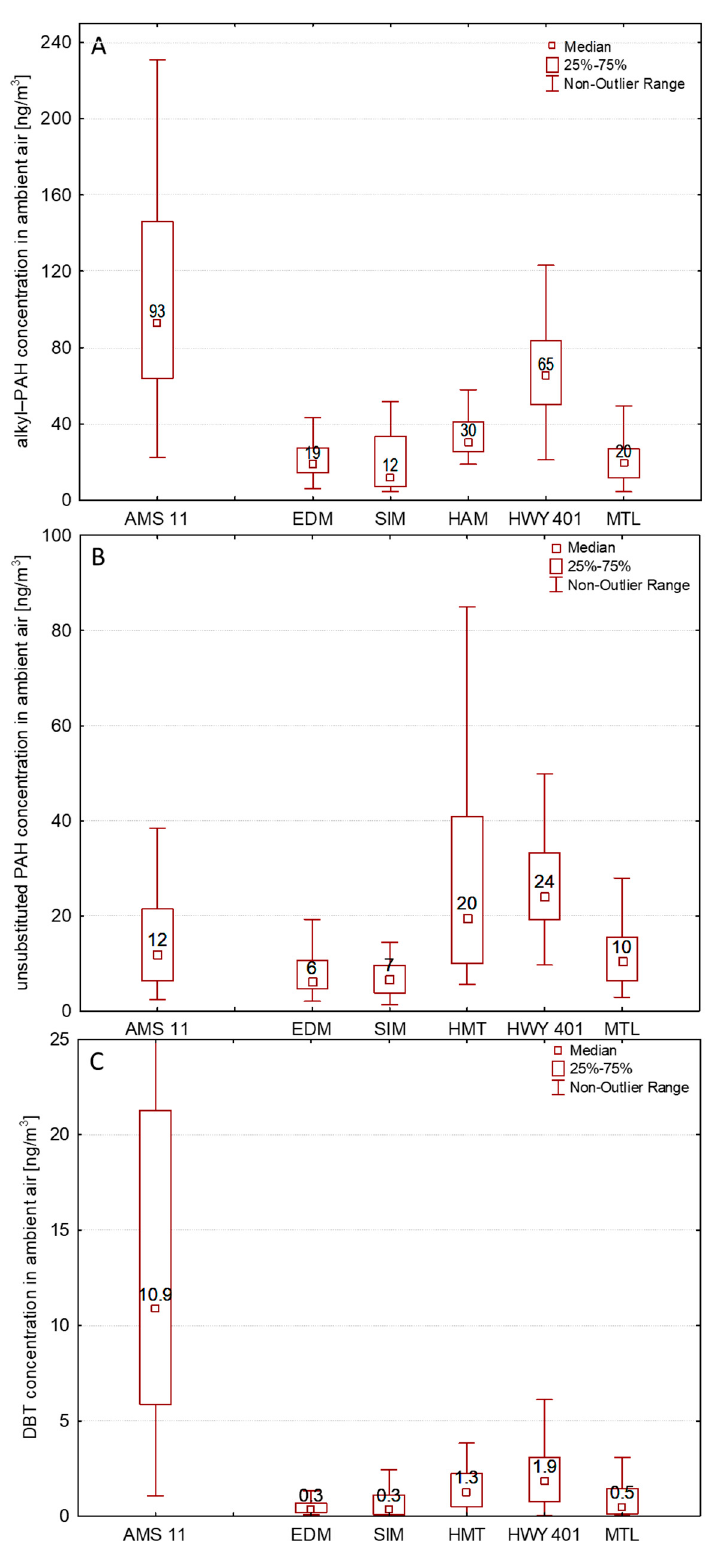
Figure 2. Median total concentrations of ( A ) alkyl-PAHs, ( B ) unsubstituted PAHs, and ( C ) DBTs (DBT + alkylated DBTs) in samples collected at the five NAPS sites. Note, median concentration of PACs collected in the Oil Sands Region (AMS11) is reported for comparison [16].